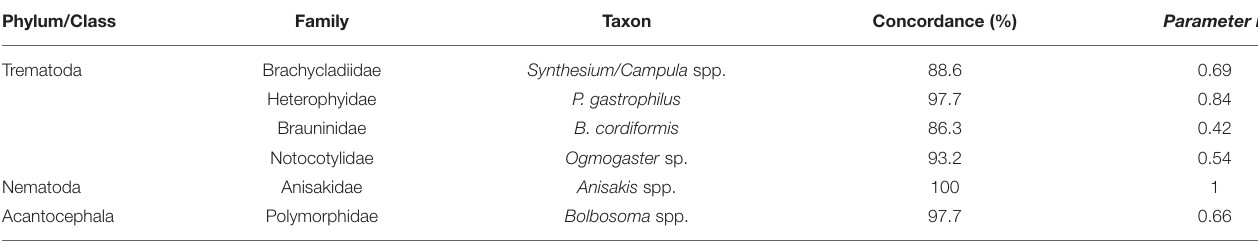
TABLE 2 | Concordance of the SF and MF methods for the detection of the helminthic